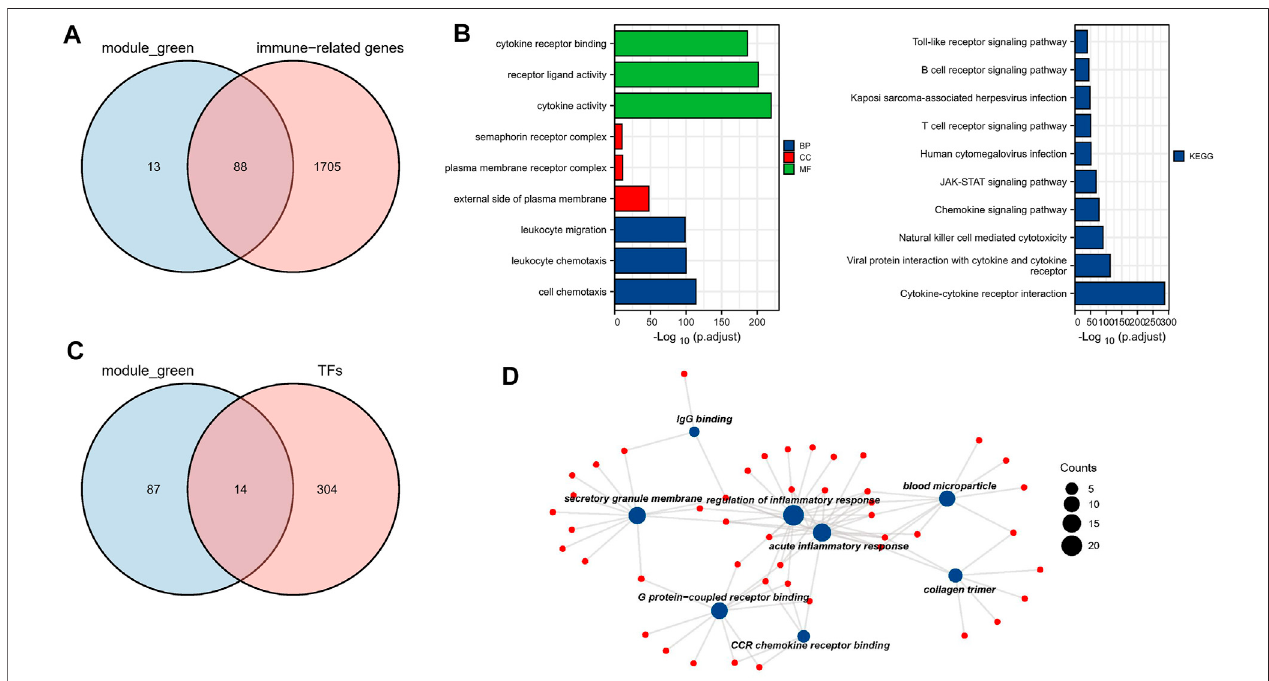
FIGURE3| BiologicalfunctionanalysisofTFsandIRGs. (A) ThevennplotofgreenmoduleandIRGs. (B) IRGsforGOandKEGGpathwayenrichmentanalysis (C) The venn plot of green module and TFs. (D) The main biological process of TFs enrichment.